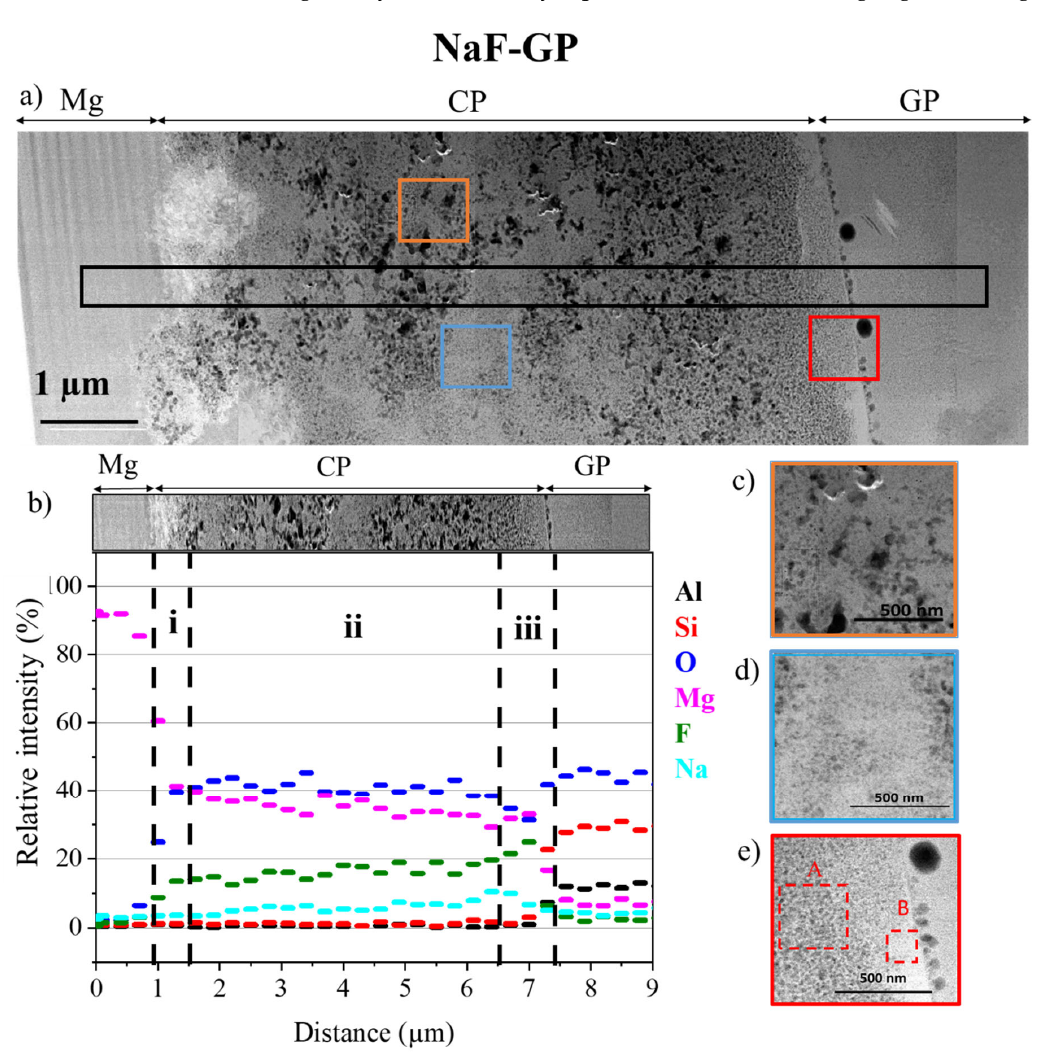
Figure 7. ( a ) Low magnification of HAADF ‐ STEM images assembly of the interface between CP, MgZr for GP ‐ NaF thin foil, ( b ) spatial distributions of elements obtained from EDX analysis (black rectangle in ( a ), zooms of the square areas enclosed in ( c ) red, ( d ) blue, and ( e ) orange in ( a ).